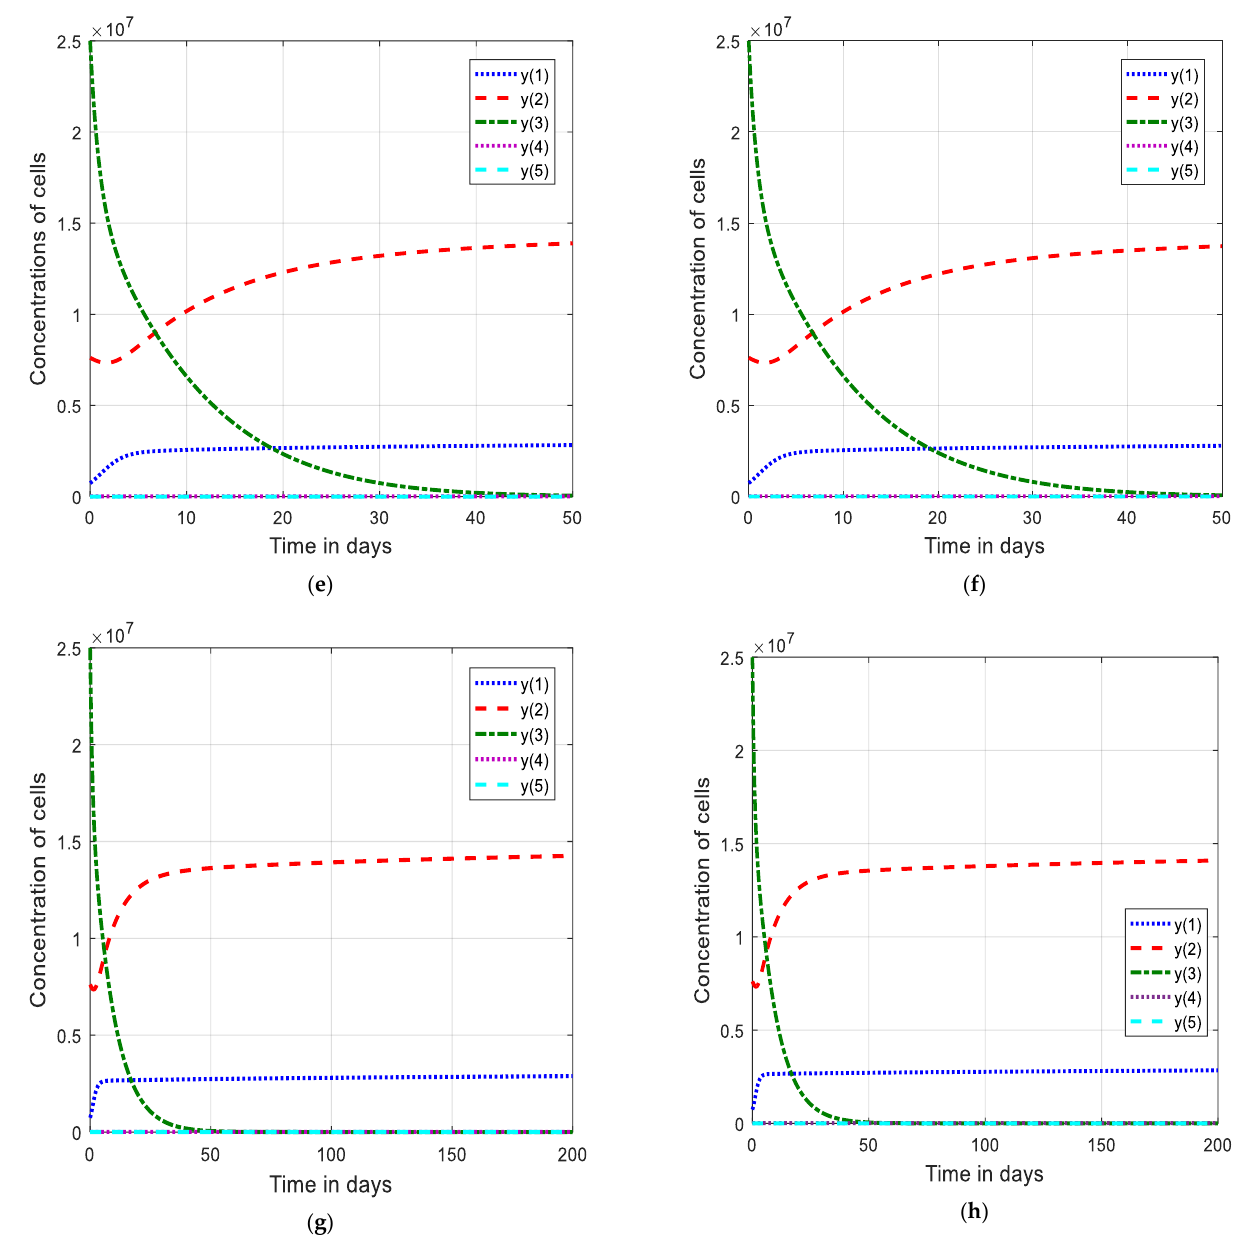
Figure 6. Rate of concentration of cells along the time t in days, stem cells y 1 ( t )[ · · ·· ] , tumor cells y 2 ( t )[ − − ] , healthy cells y 3 ( t )[ − · −· ] , immune cells y 4 ( t )[ · · ·· ] , estrogen y 5 ( t )[ − − ]